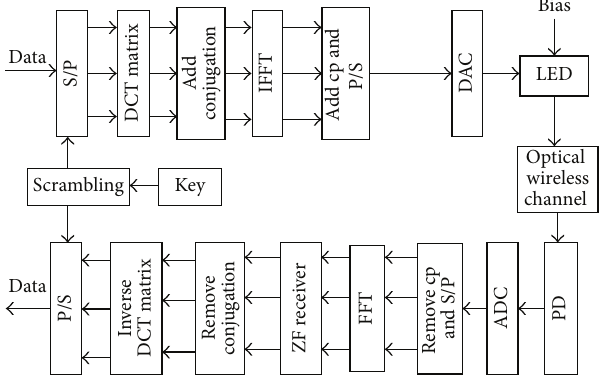
Figure 7: DCT precoded OFDM-based VLC system with encryp- tion and decryption.